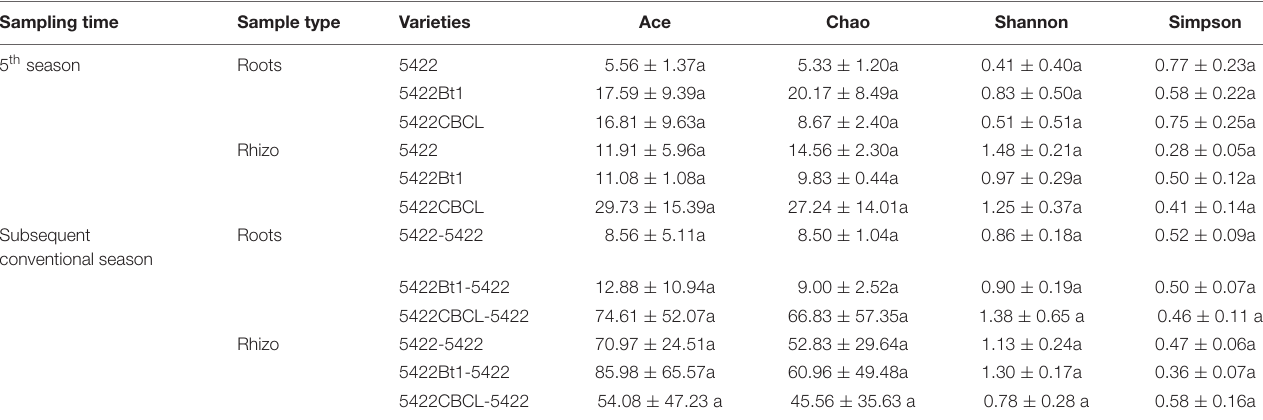
TABLE 1 | Richness estimators and diversity indices of AMF communities sampled at the maturity period of the fifth season Bt and non-Bt maize varieties and seedling period of the subsequently conventional maize variety. Sampling